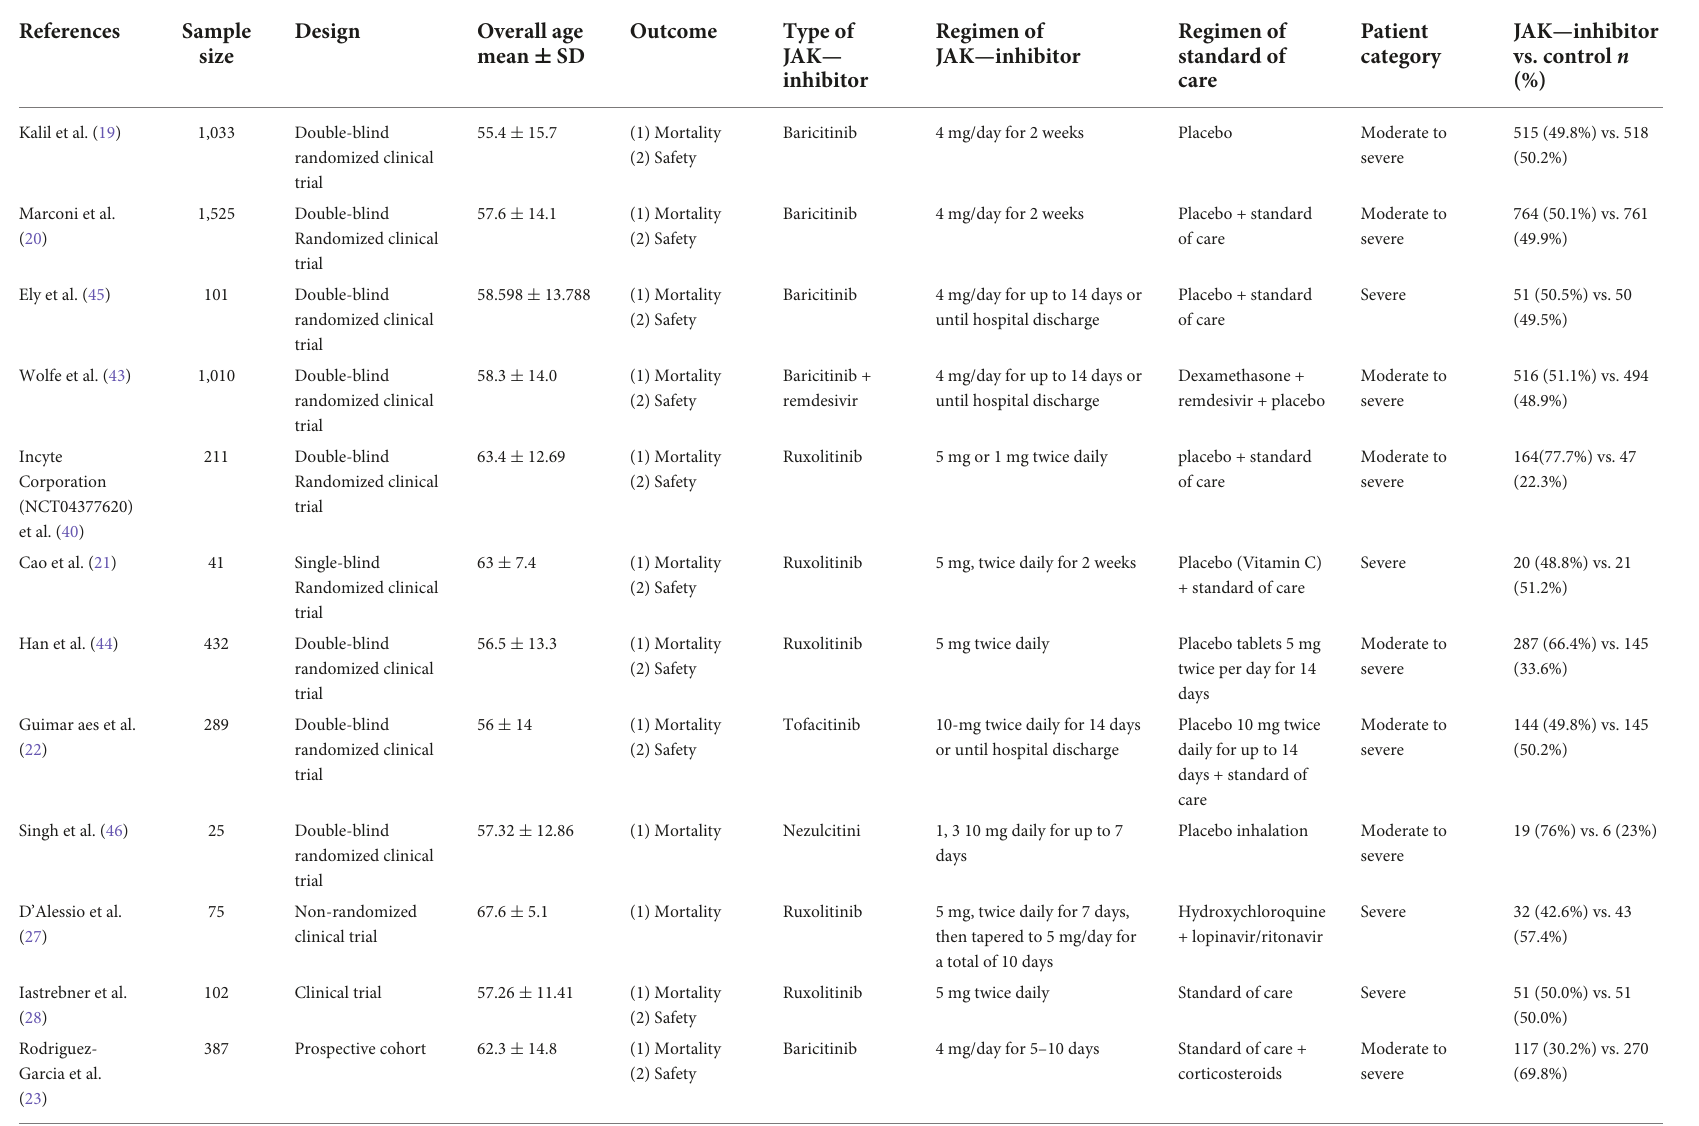
TABLE 1 Characteristics of studies included in the